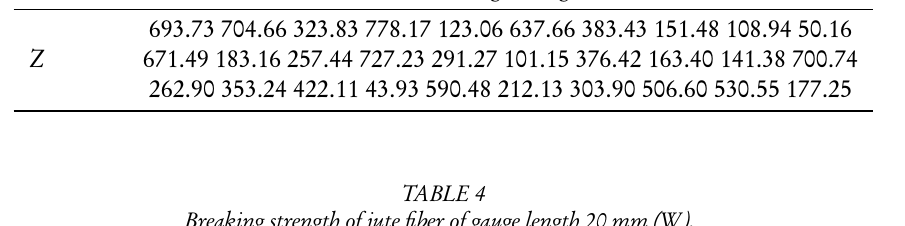
Breaking strength of jute fiber of gauge length 20 mm (W